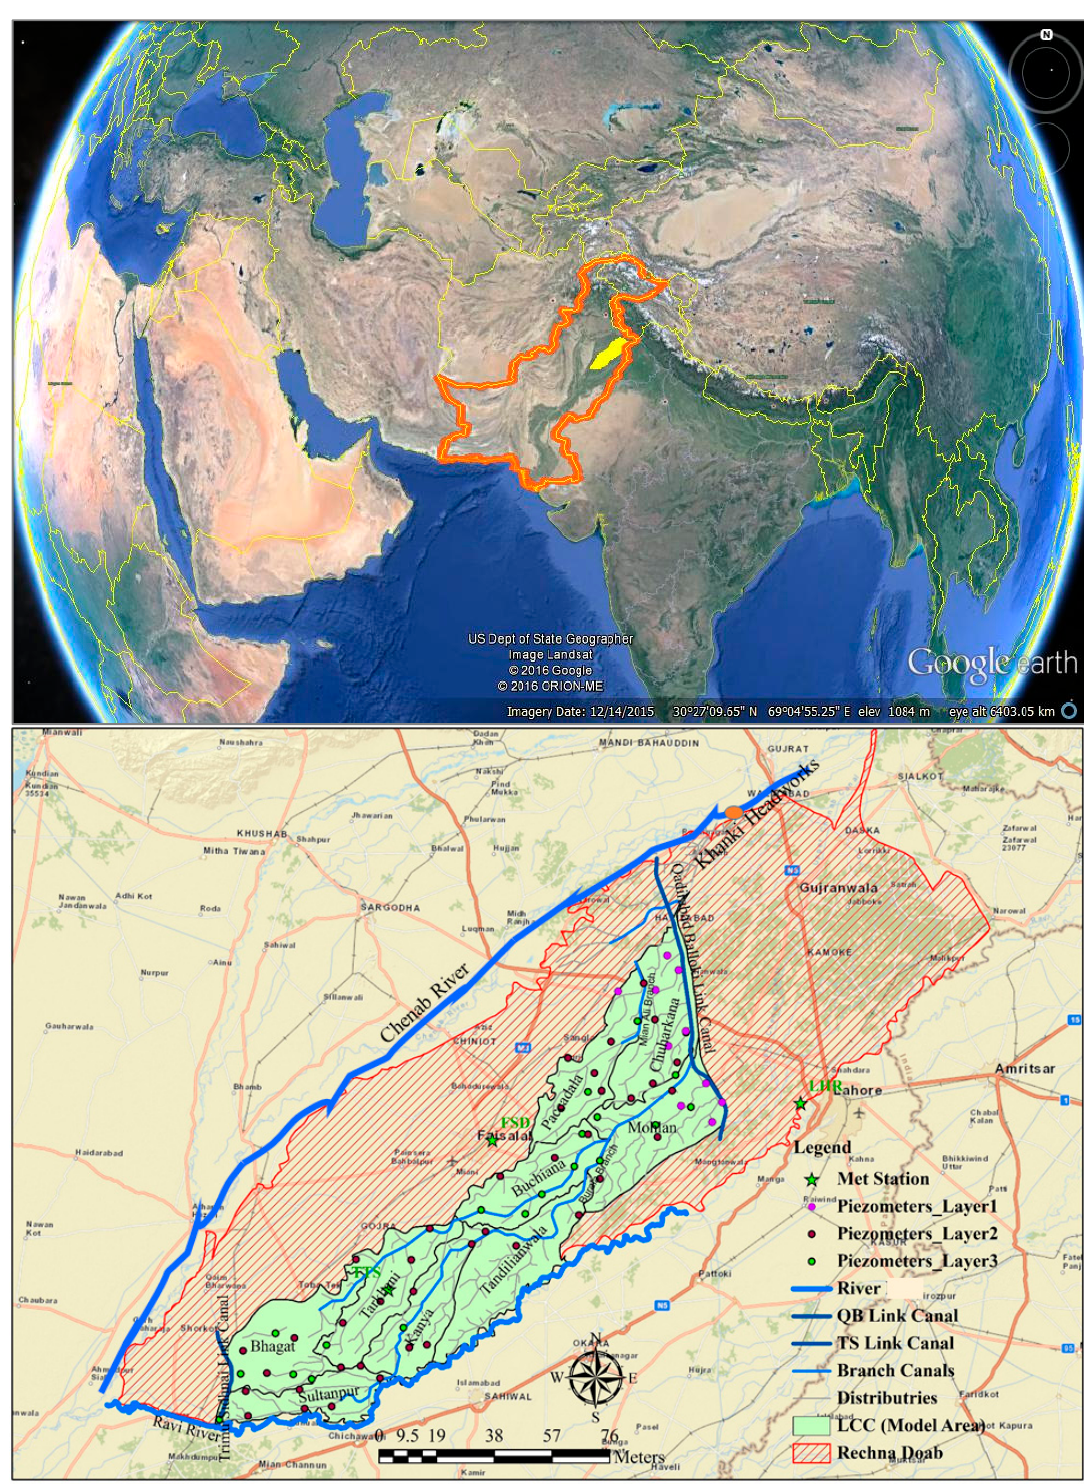
Figure 1. Location and details of the study area.